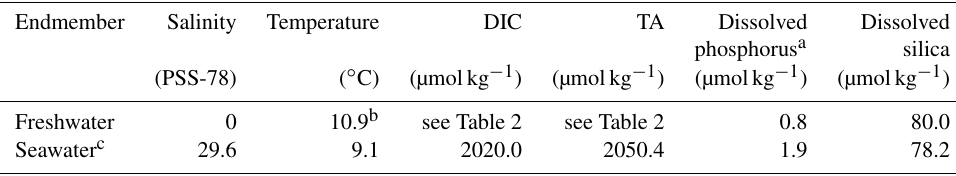
Table 1. Model freshwater and seawater endmembers used to prescribe river fluxes and values at the 40m boundary.